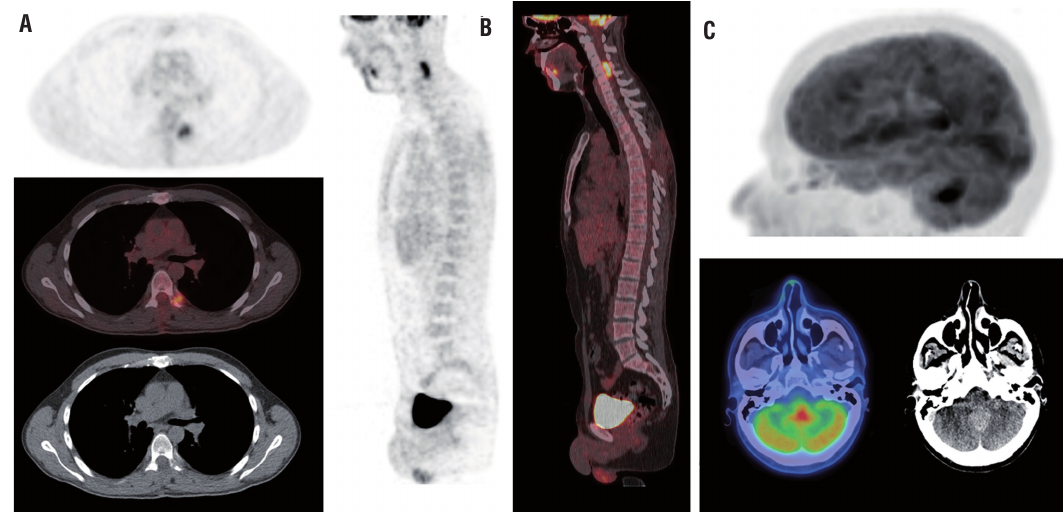
Figure 1 - Wholebody and cerebral 18F-FDG PET/CT scan after i.v. administration of 370 MBq of 18F-FDG. Panel a) Axial images that revealed an augmentation of soft tissue due left T6 laminectomy with increased uptake of radiotracer and SUV maximum of 4.84 that cannot allow to excluded the persistence of tumour tissue. Panel b) Sagital images showed a spinal cord metastasis with increased uptake of radiotracer at C4-C5 vertebral levels with a SUV maximum of 7.49. Panel c) Cerebral scan revealed a hypermetabolic mass in cerebellum, with high uptake of 18F-FDG (SUV maximum of 11), corresponding with 3.9 cm mass in vermix observed at post-hoc MRI